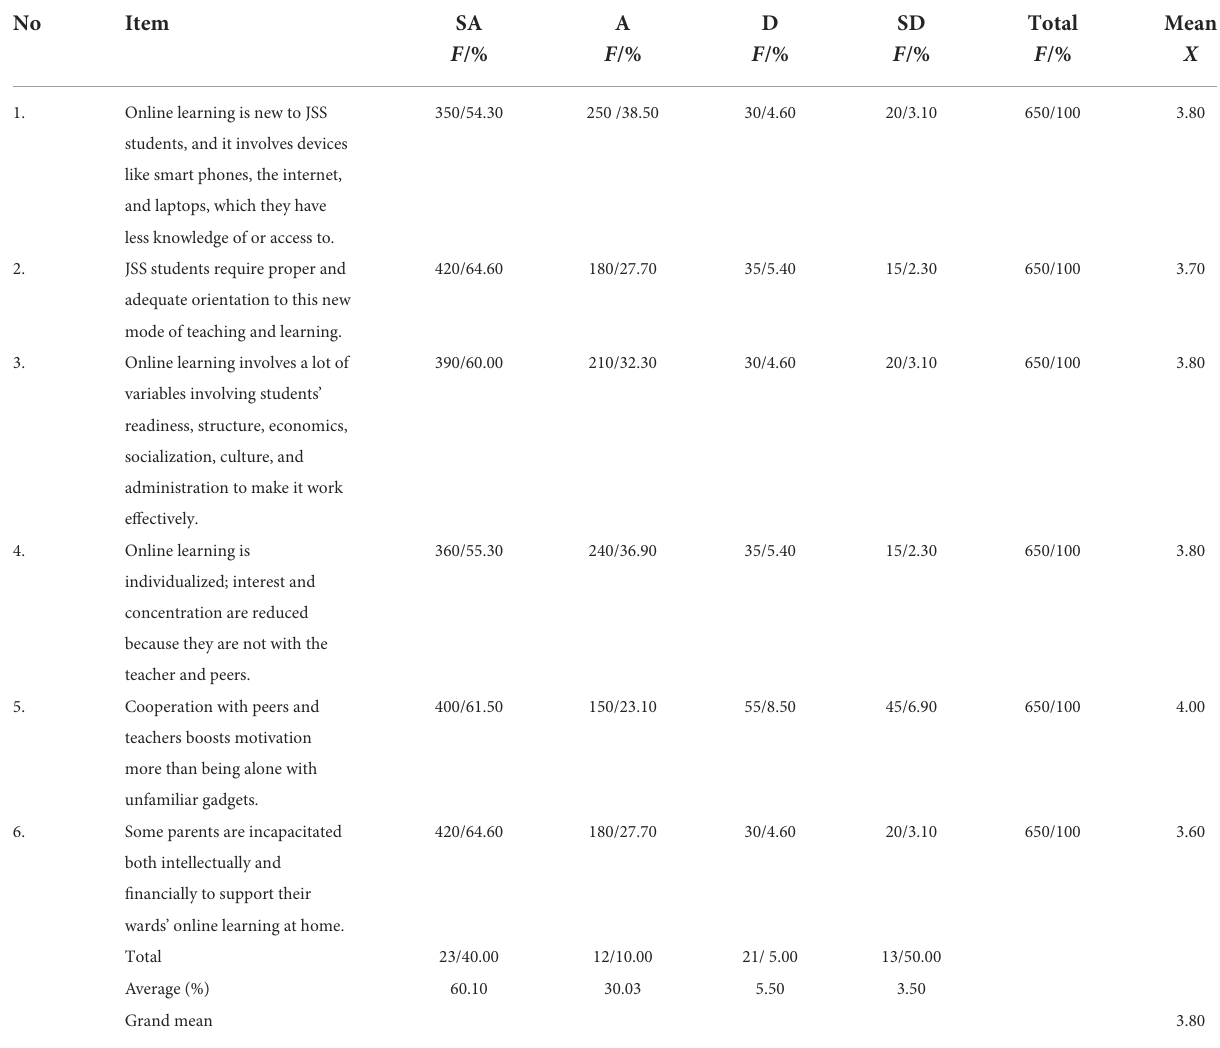
TABLE 1 Responses on the impact of a sudden shift to online learning on JSS